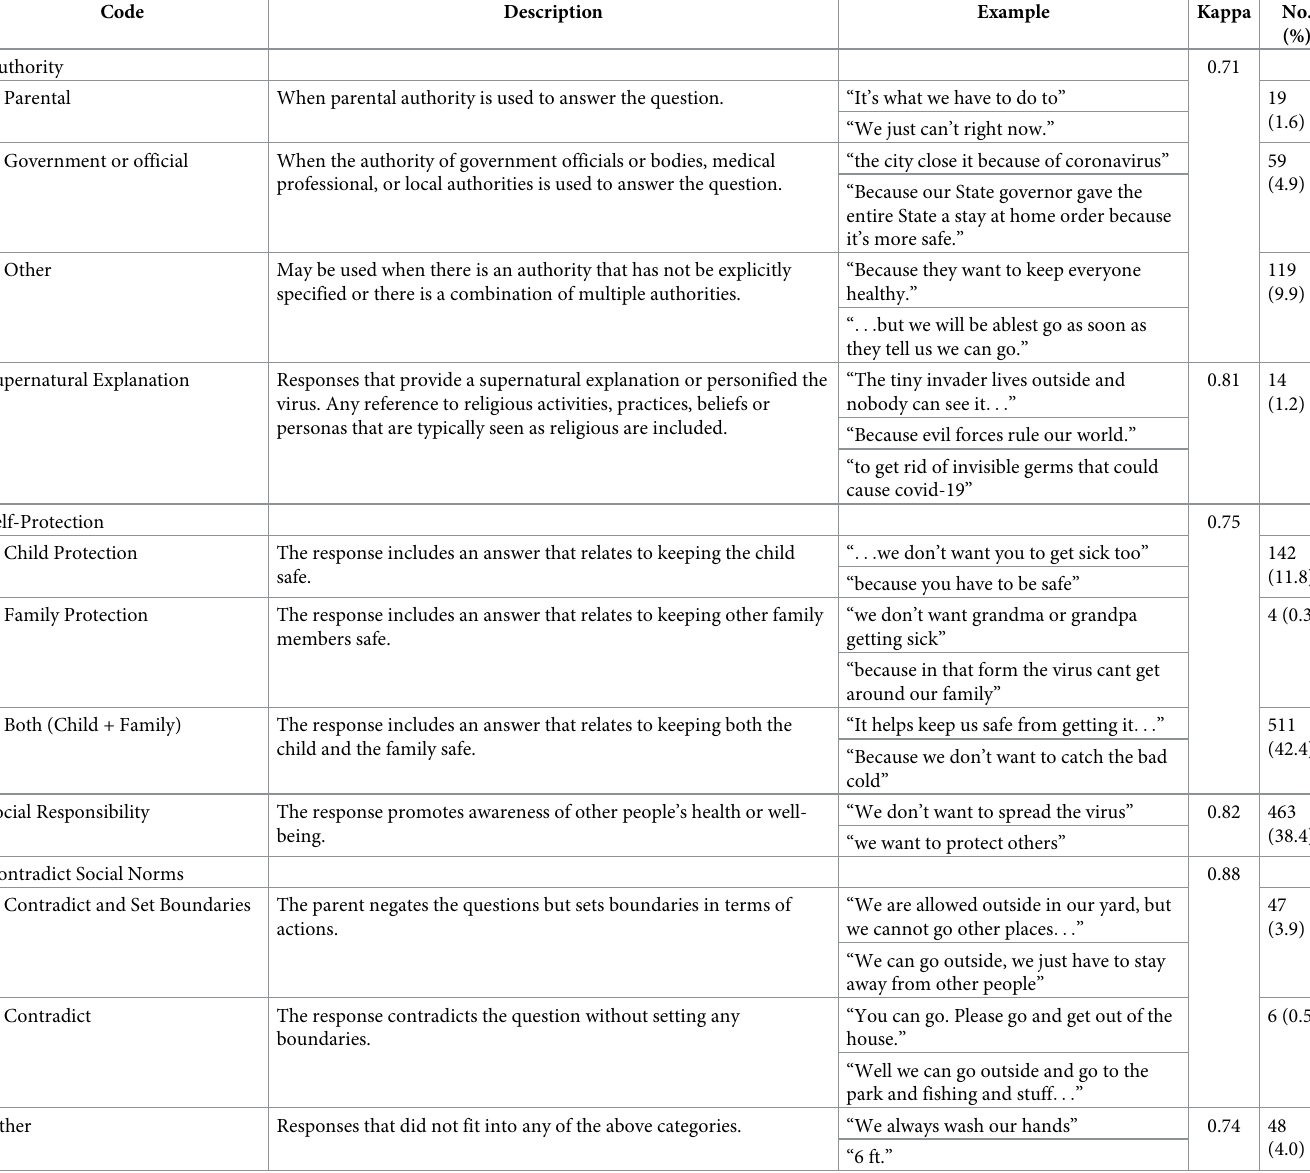
Table 5. Coding for parent’s responses to targeted